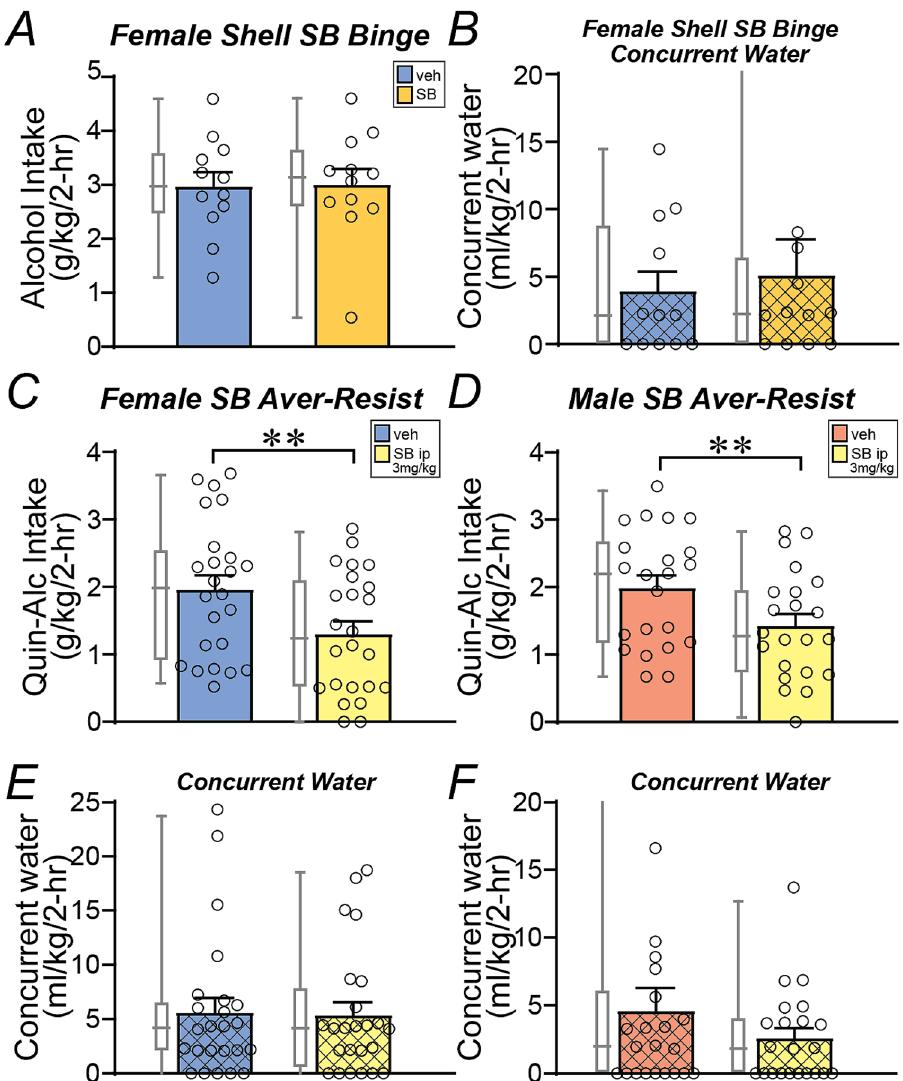
Figure 1. Ox1R inhibition and regulation of binge and compulsion-like drinking in female C57 mice. ( A , B ) Intra-shell infusion of the Ox1R inhibitor SB did not alter ( A ) alcohol-only consumption under LDA (2-h per day drinking), nor ( B ) did it reduce concurrent water intake. ( C , D ) Systemic administration of a lower dose of SB (3 mg/kg) significantly reduced quinine-resistant alcohol drinking in both ( C ) females and ( D ) males. ( E , F ) However, lower dose SB did not significantly reduce concurrent water intake in either sex, suggesting a specific effect of systemic SB on compulsion-like alcohol consumption. One data point in ( B ) for SB was 32.7 ml/kg and in ( F ) for vehicle was 33.6 ml/kg, not shown on graphs. For Figs. 1, 2, 3 and 4, box-whisker plot (see “Material and methods”) is for the same data shown in adjacent colored bar. Aver-Resist: aversion-resistant drinking; Quin-Alc: quinine (100 µM) in alcohol. ** p <